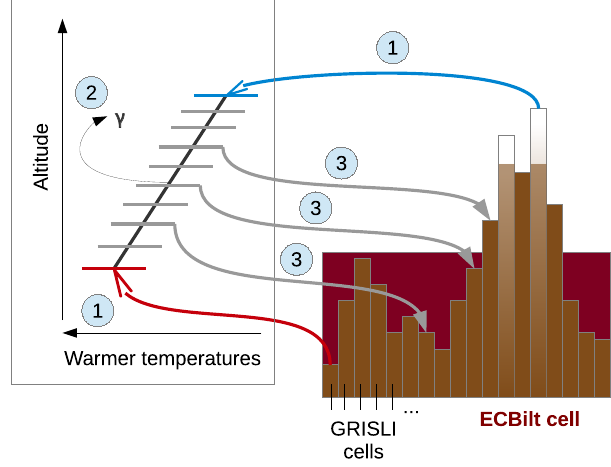
Figure 5. Scheme presenting the method used for the vertical downscaling. Numbering indicates the order of processing. (1) the temperature at the highest and lowest GRISLI point (tails of the blue and red arrows respectively) is retrieved for the given ECBilt grid cell (boundary in violet). (2) A vertical lapse rate γ is computed from the these two extreme temperatures, using the line defined by the two temperatures and elevation extrema in addition to the EC- Bilt cell temperature. (3) Using γ , temperatures are derived for all altitudes in GRISLI if the latter are